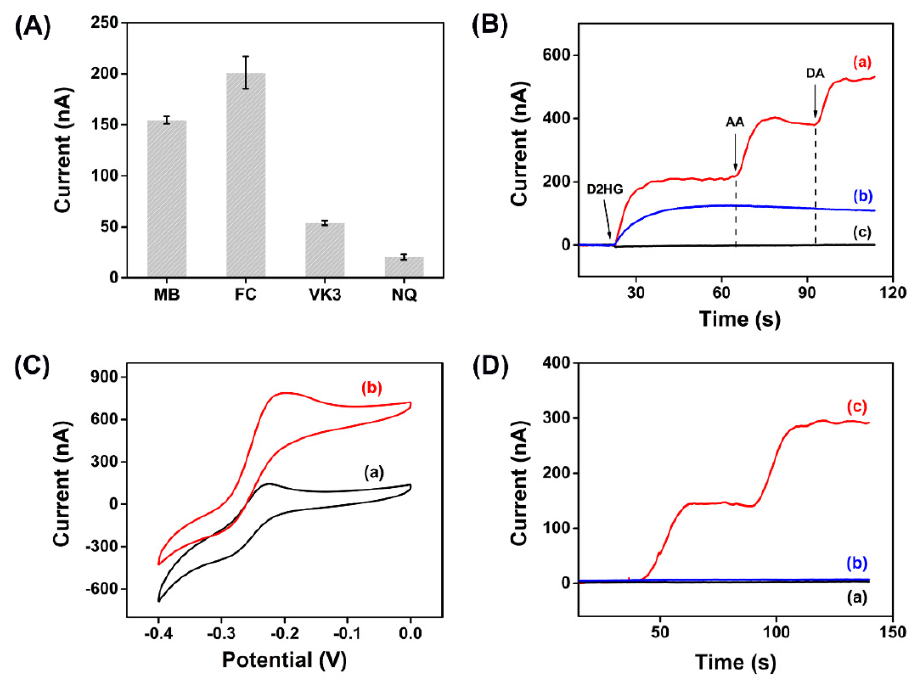
Figure 2. ( A ) Current response of enzymatic electrodes with different electron mediators for 50 µ M D2HG in 50 mM PB (pH 7.0) with 0.1 M KCl; ( B ) i–t curves of enzymatic electrodes with (a) FC, (b) MB and (c) no mediator in 50 mM PB with 0.1 M KCl after adding 50 µ M D2HG, 200 µ M ascorbic acid (AA) and 200 µ M dopamine (DA), respectively; ( C ) CV curves of the Rs D2HGDH/MB/MXene/AuSPE with (a) 0 µ M and (b) 1 mM D2HG in 50 mM PB (pH 7.0) with 0.1 M KCl at a scan rate of 10 mV s –1 vs. Ag/AgCl; ( D ) i–t curves of the (a) AuSPE, (b) MX- ene/MB/AuSPE and (c) Rs D2HGDH/MB/MXene/AuSPE in 50 mM PB (pH 7.0) with 0.1 M KCl with the stepwise addition of 50 µ M D2HG. Applied potential: − 0.23 V vs.